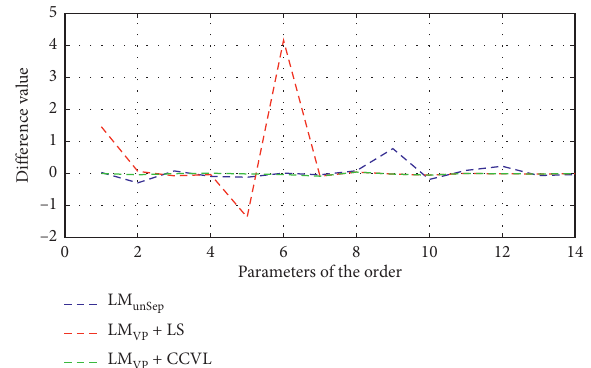
Figure 6: Difference between the true value and the estimation of parameters obtained using the three methods in Example